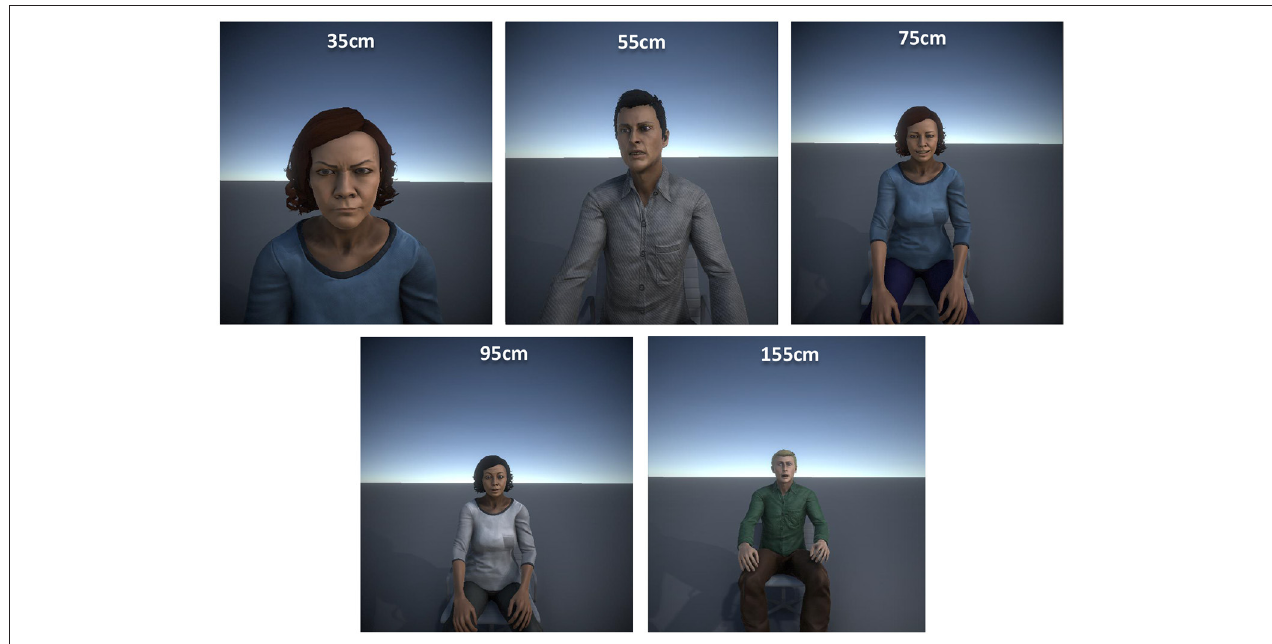
FIGURE 2 | Virtual humans as seen by participants using the HMD for each of the distances considered.